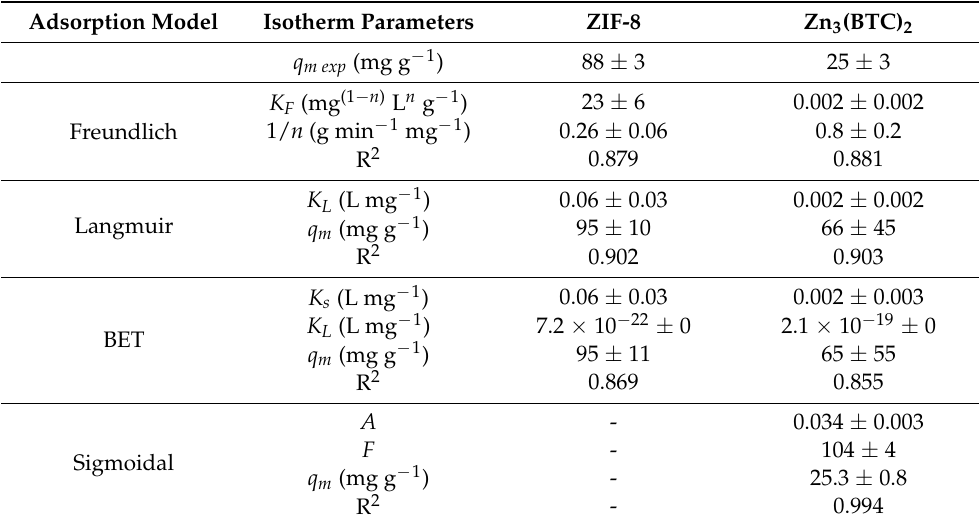
Table 1. Isotherm parameters were obtained by fitting the experimental data for OFL adsorption onto ZIF-8 and Zn 3 (BTC) 2